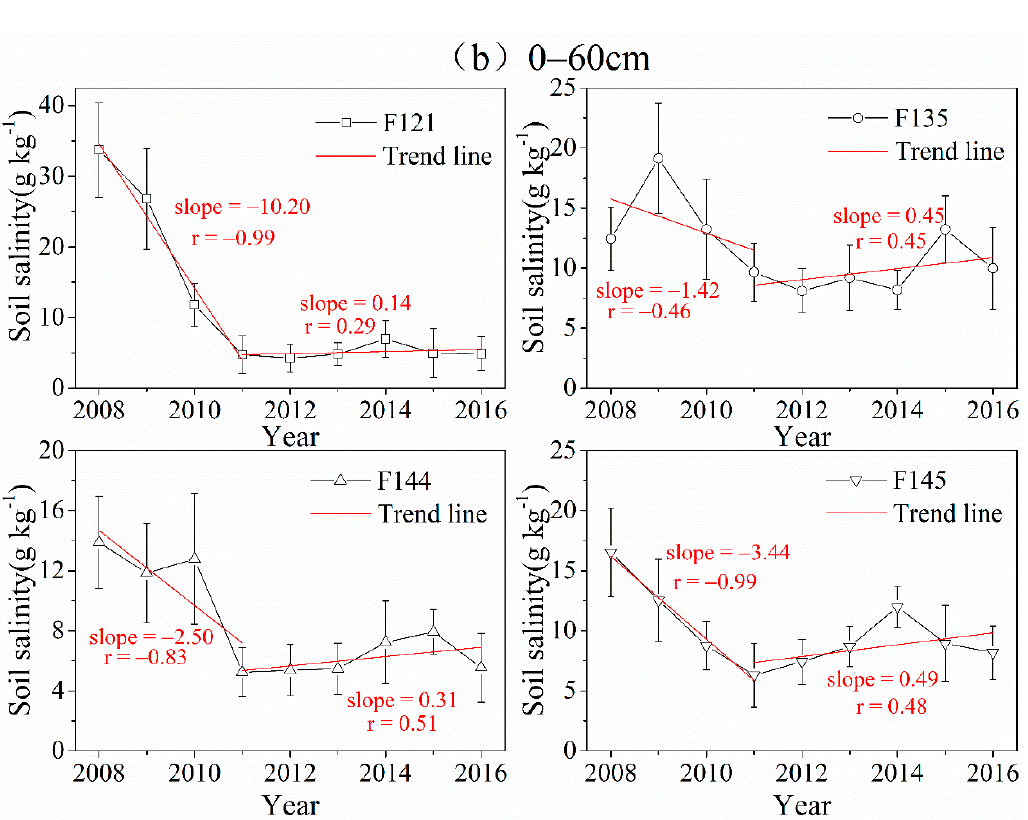
Figure 3. Dynamics of soil salinity in 0–30 cm ( a ) and 0–60 cm ( b ) layers.